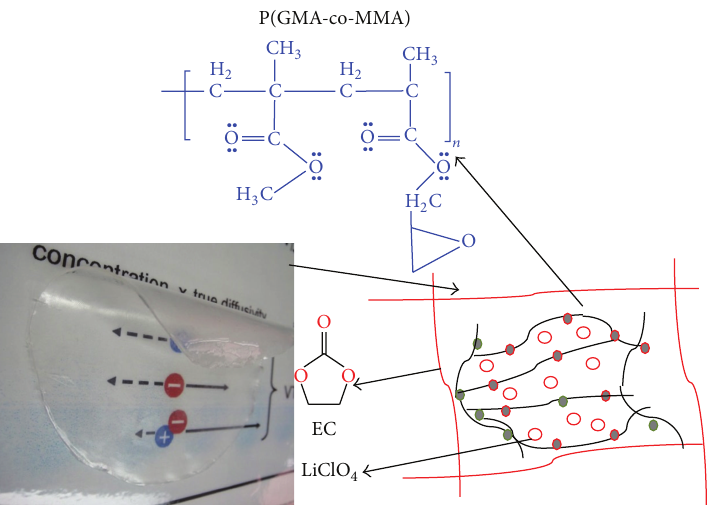
Figure 1: Appearance of P(GMA-co-MMA)-LiClO 4 -EC.